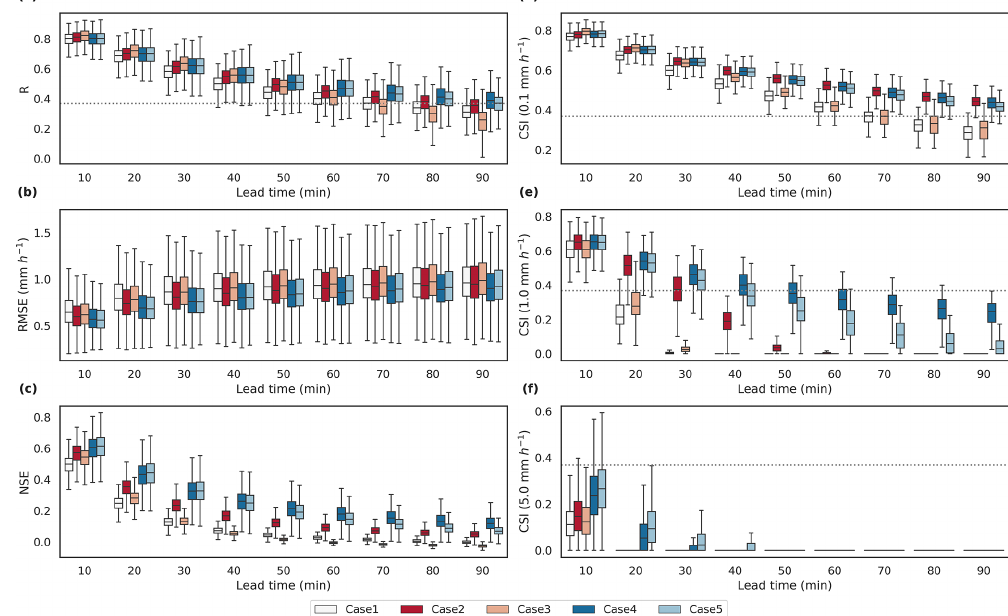
Figure 8. Box plots of the verification metrics of model predictions at the lead time up to 90min over all grid cells from the Andong Dam basin. Panels (a) – (c) represent R , RMSE, and NSE, and (d) – (f) represent CSI at intensity thresholds of 0.1, 1.0, and 5.0mmh − 1 respectively. Dotted gray line represents the predictability threshold (1 /e